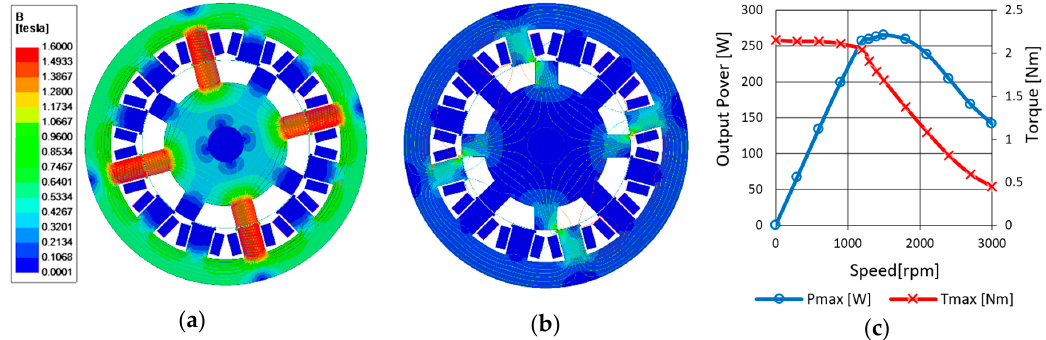
Figure 2. Magnetic field distribution in the finite element method (FEM) model, phase current 6 A: ( a ) aligned position, rotor angle 22.5 degrees; ( b ) rotor angle 7.2 degrees; ( c ) Power–Speed and Torque–Speed characteristics.